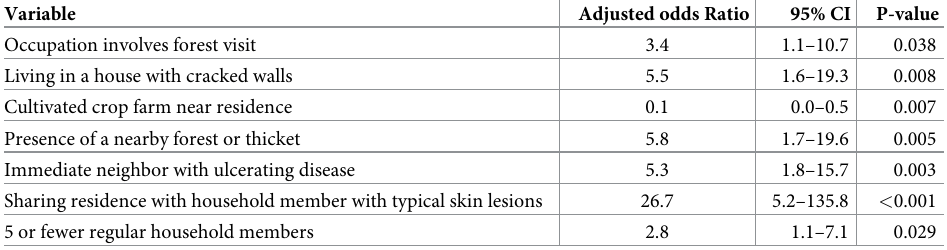
Table 4. Final model showing adjusted odds ratios and 95% confidence intervals for factors related to cutaneous leishmaniasis in Gilgil-Kenya,